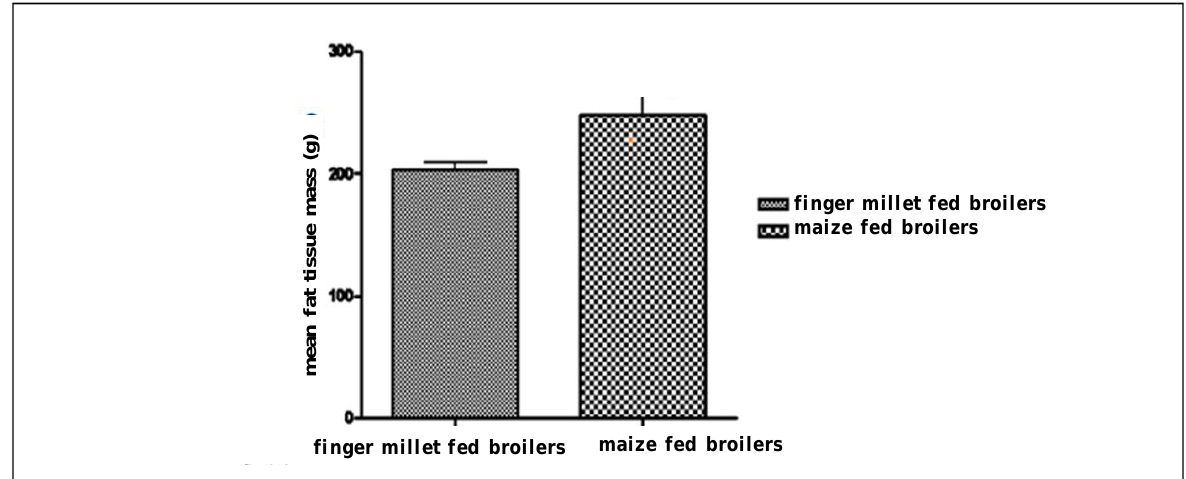
Statistically finger millet feed did not affect fat deposition in broilers (t